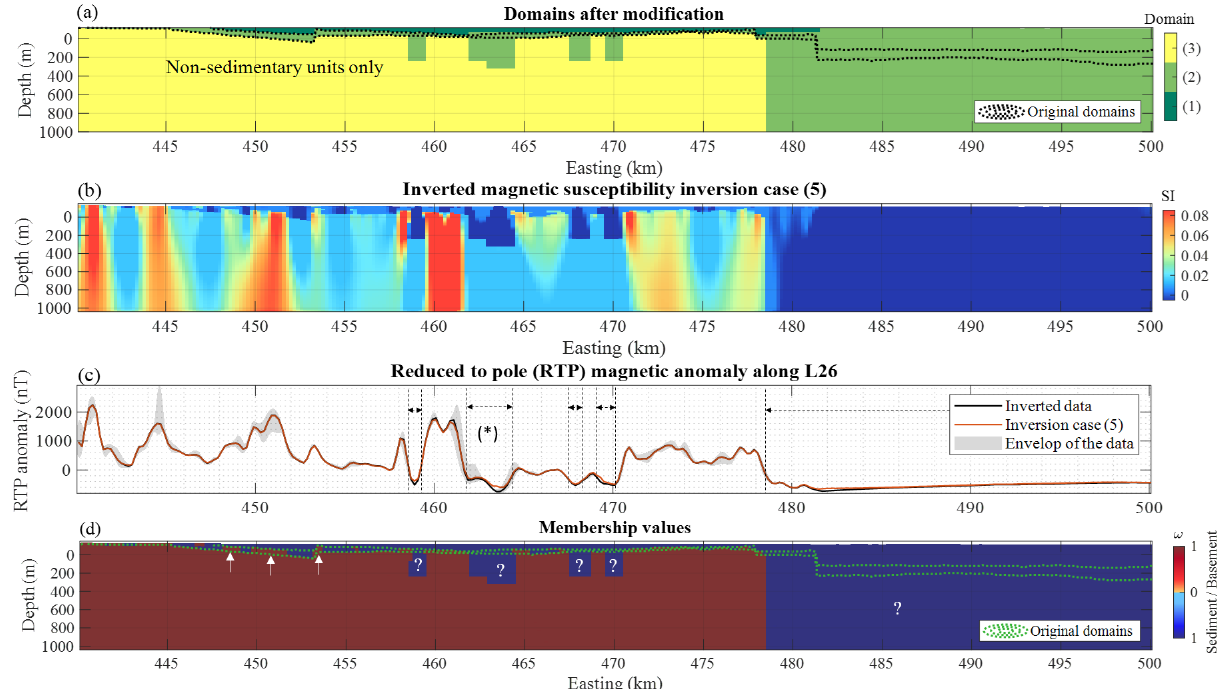
Figure 12. (a) MT-derived domains adjusted following the adjustments suggested by magnetic data inversion, for domains with (1) sedimen- tary units only, (2) sedimentary and non-sedimentary units, and (3) non-sedimentary units only. Panel (b) is the inverted model for inversion case (5), and panel (c) is the inverted and field magnetic RTP data, with the horizontal extent of the locations where MT bounds are adjusted. Panel (d) shows the membership values to the sedimentary and basement units obtained using Eq. (10), overlaid with the original contours of MT-derived domains. In (c) , the grey shading shows the envelope of the data shown in Fig. 9 for calculating the weighted average of the inverted